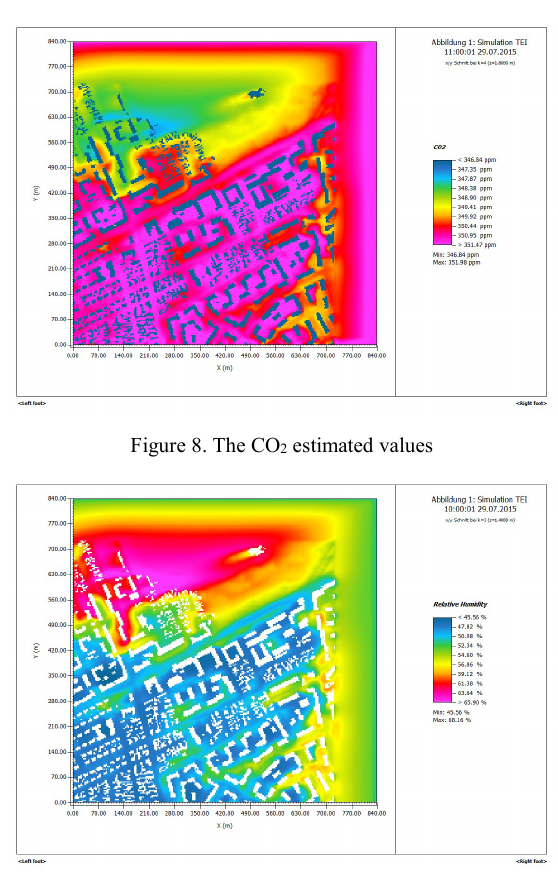
Figure 9. The relative humidity estimated